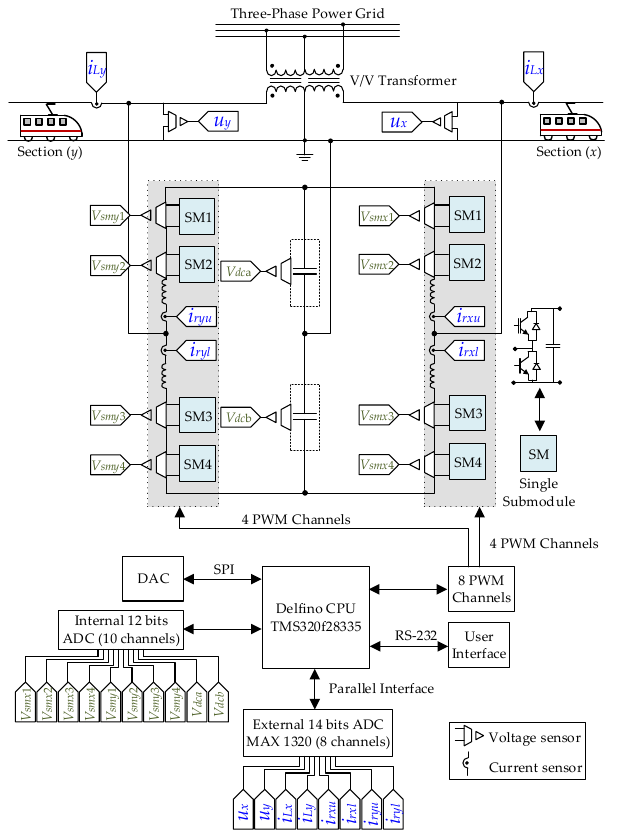
Figure 15. Global communication structure of the reduced-scale prototype RPC based on half-bridge